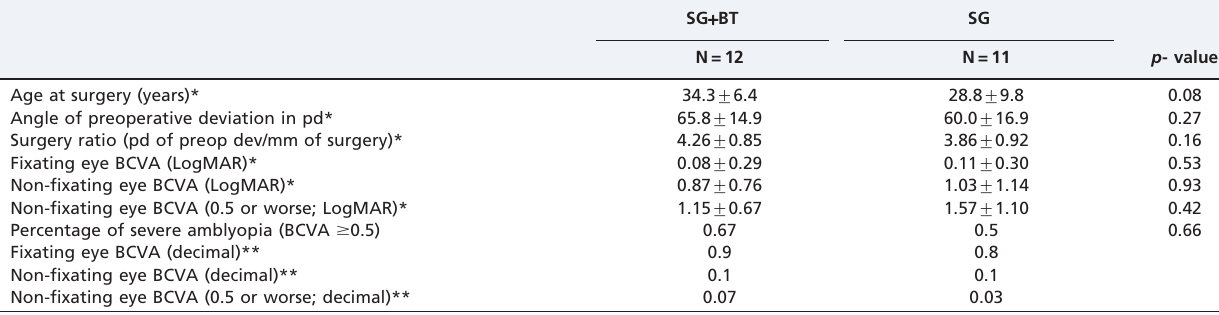
* mean ¡ SD. ** mean values. BCVA = best corrected visual acuity. Pd = prism diopter.